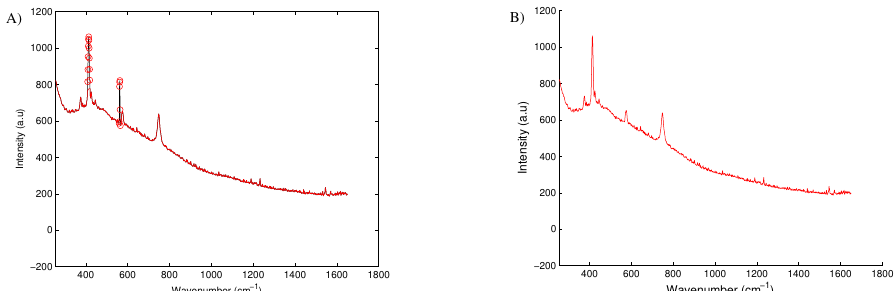
Figure A2. Example of spectra containing a cosmic ray with ( A ) highlighting the outlier peaks identified by the de-spiking function and ( B ) highlighting the final spectra with the cosmic ray removed. The cosmic ray located at 560 cm − 1 is correctly identified as an outlier, however this function also wrongly identified the strong sapphire peak located at 410 cm − 1 as an outlier. This demonstrates the importance of viewing each of the identified outliers before they are blindly